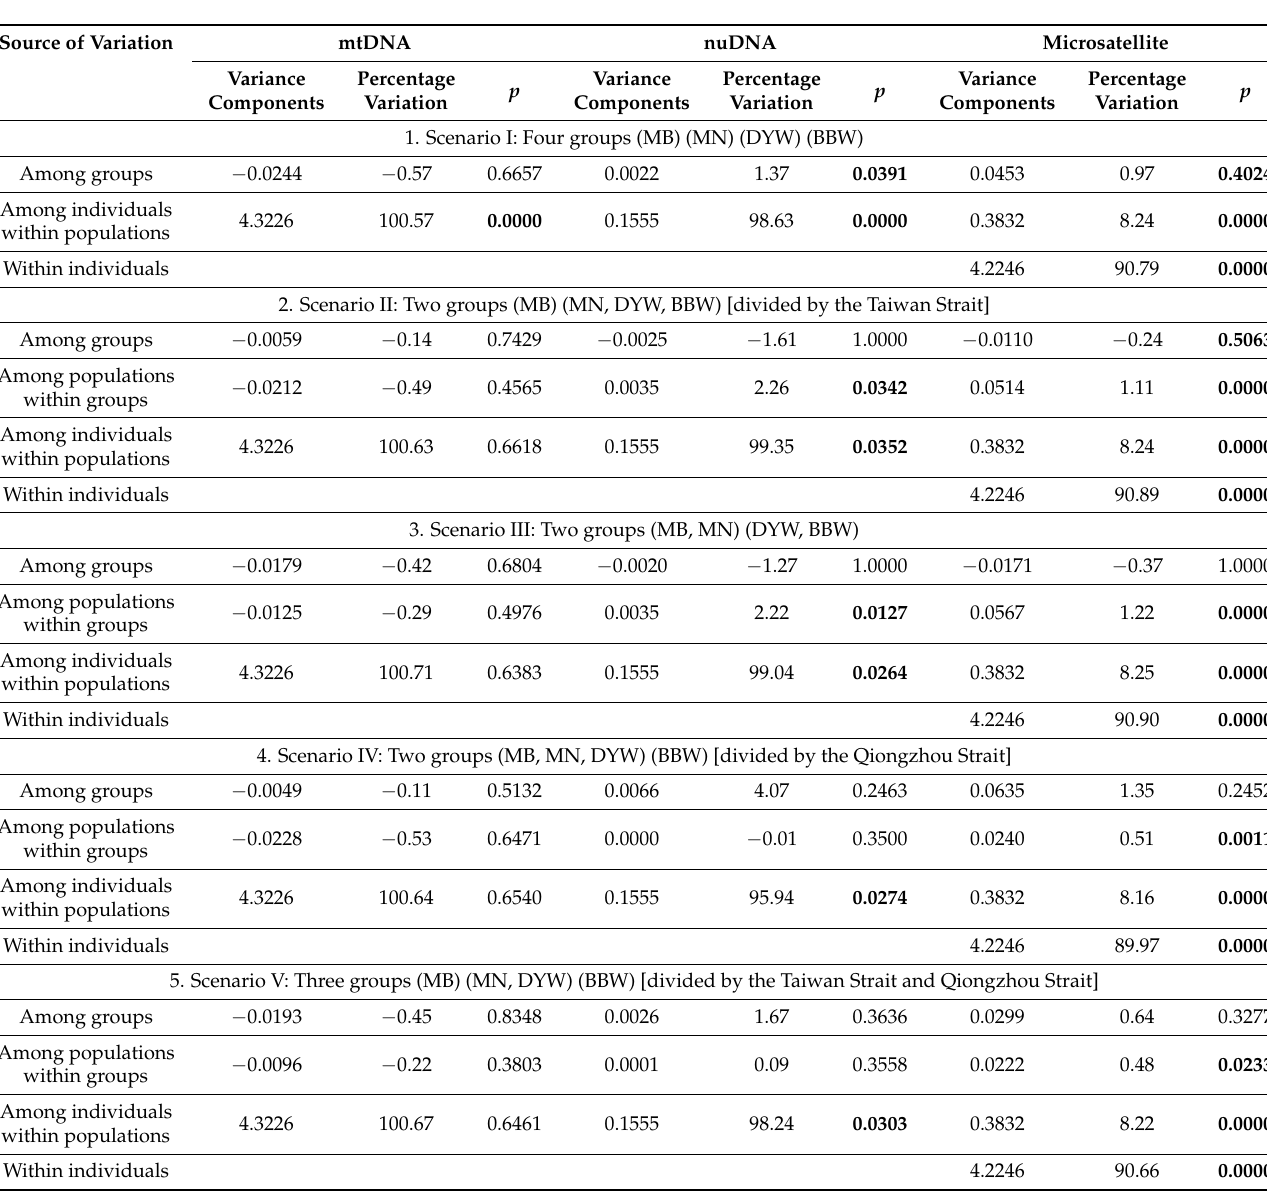
Table 3. Analysis of molecular variance (AMOVA) for E. awoara populations based on mtDNA, nuDNA and microsatellite